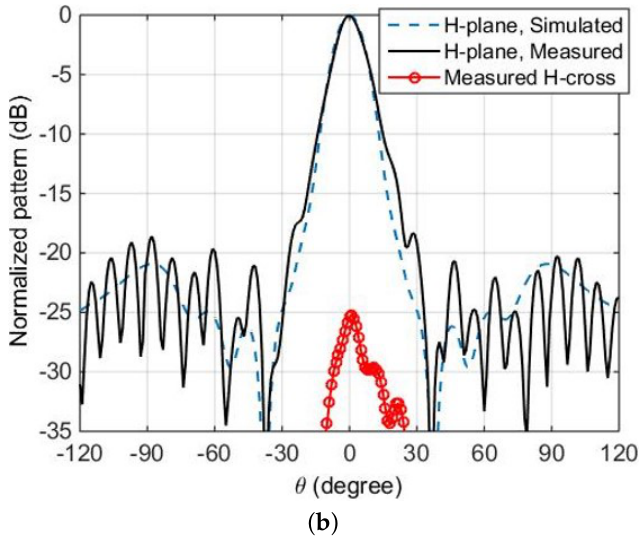
Figure 7. Normalized radiation patterns of the RCA at f c = 12 GHz in ( a ) E-plane and ( b ) H-plane.